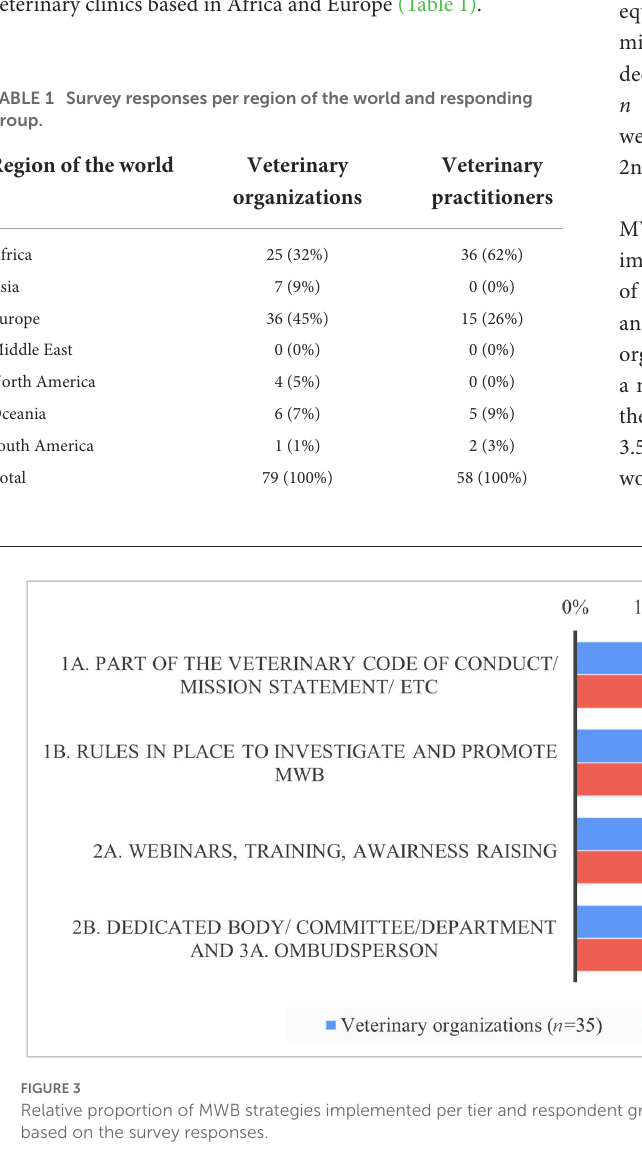
FrontiersinVeterinaryScience